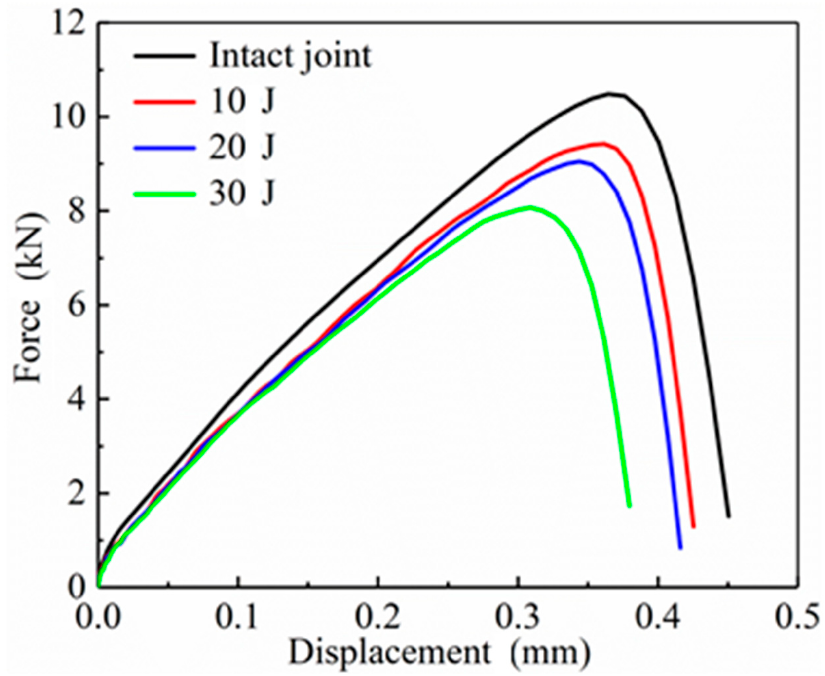
Figure 18. The load–displacement curves of SLJs in axial tension under different impact energies.